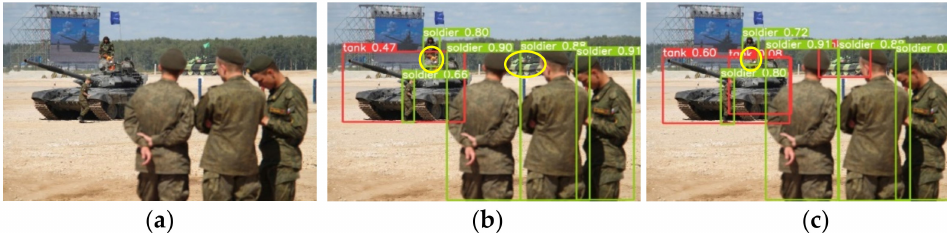
Figure 11. The detection result of scene 2. ( a ) Original image sample; ( b ) Detection results of the YOLOv5 algorithm; ( c ) Detection results of SMCA- α -YOLOv5